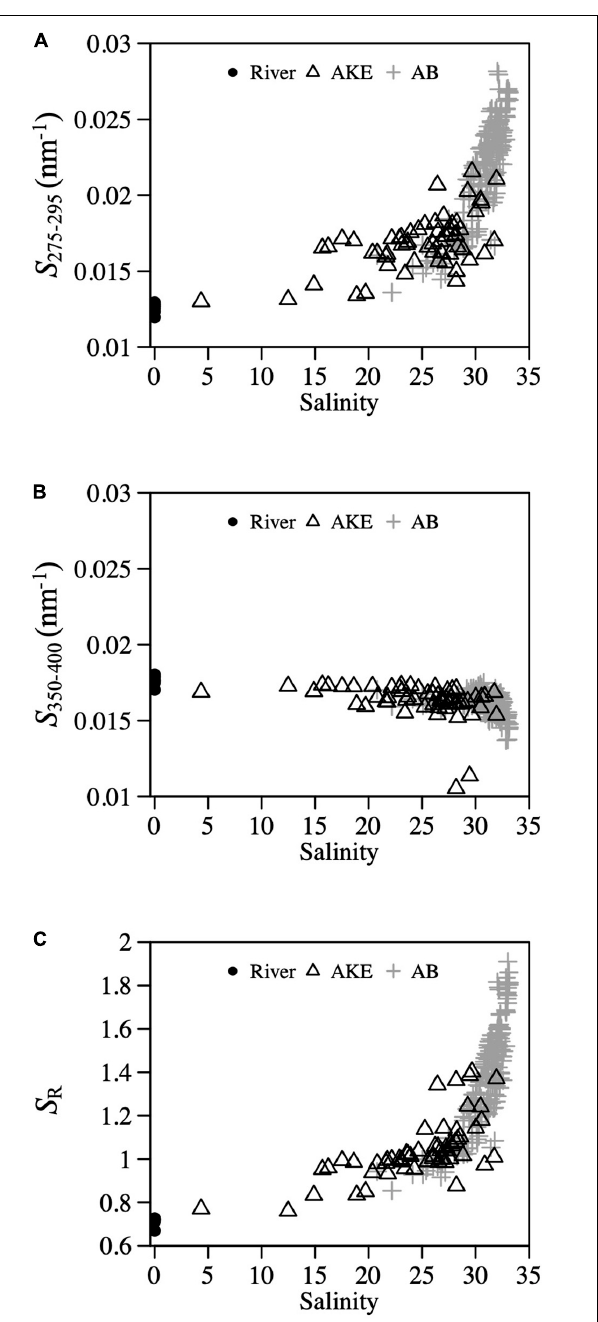
FIGURE 6 | Relationships between salinity and (A) S 275 − 295 , (B) S 350 − 400 , and (C) S R